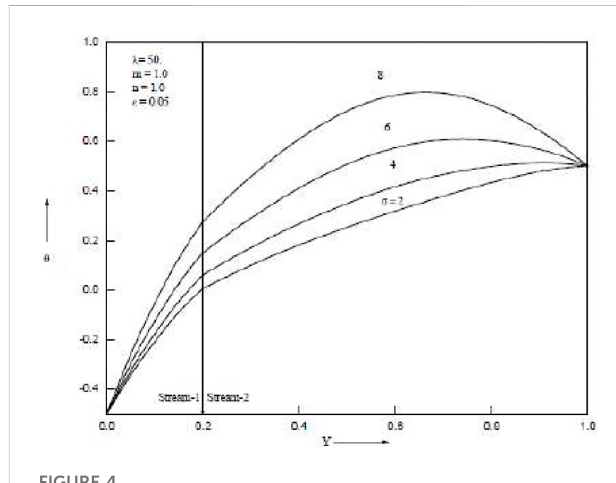
FIGURE 2 Velocity for different values of σ = 2, 4, 6, 8.